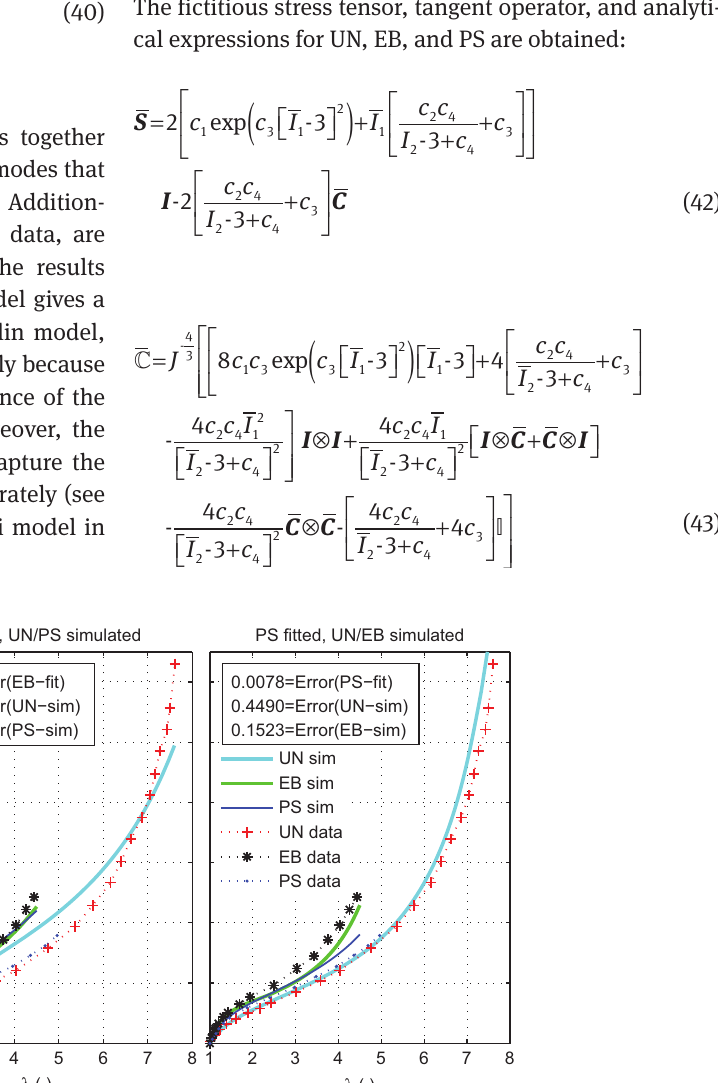
In Eq. (41), c , c , c , and c are the material para meters. 1 2 3 4 The fictitious stress tensor, tangent operator, and analyti- cal expressions for UN, EB, and PS are obtained: